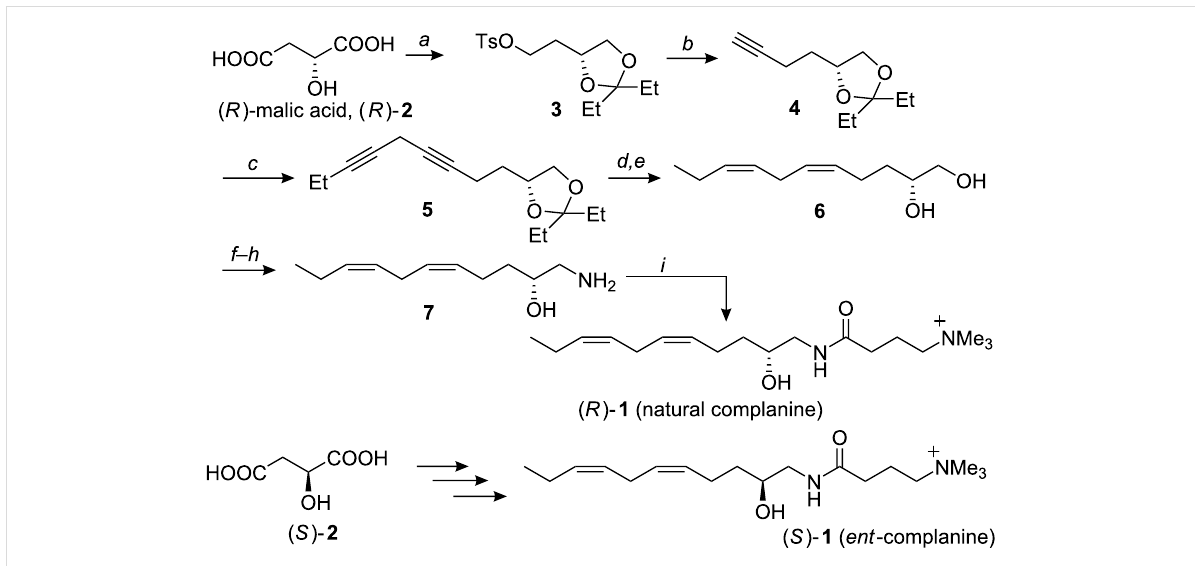
thus, the biological properties of complanine can be understood as controlling this cascade